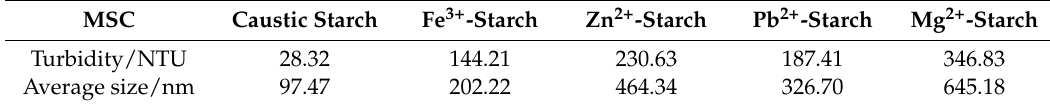
Table 1. Turbidity and average size of the MSC at pH 13.27 (NTU: Nephelometric Turbidity Unit).